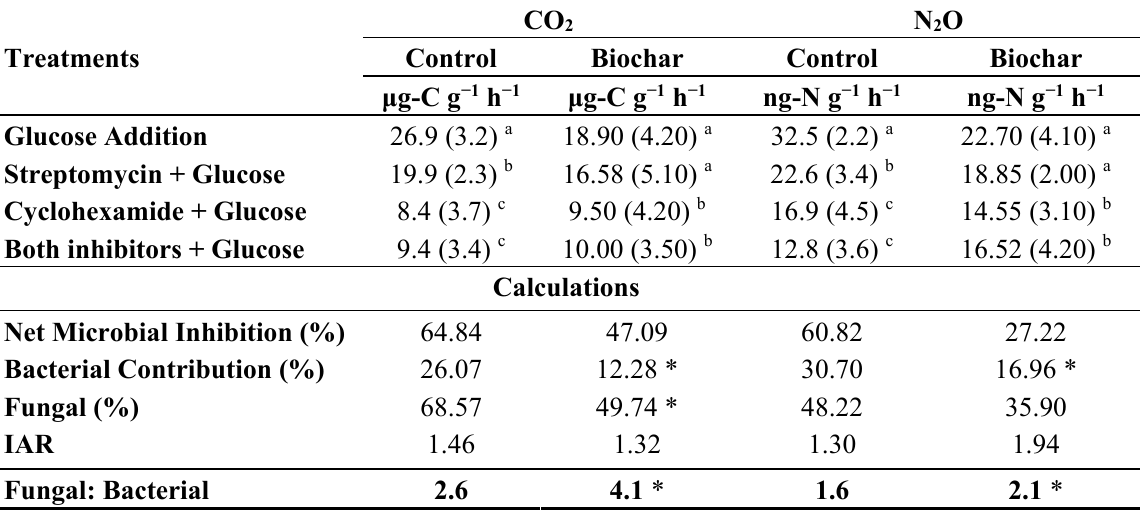
Table 2. Selective inhibitor incubation results for the prairie soil.